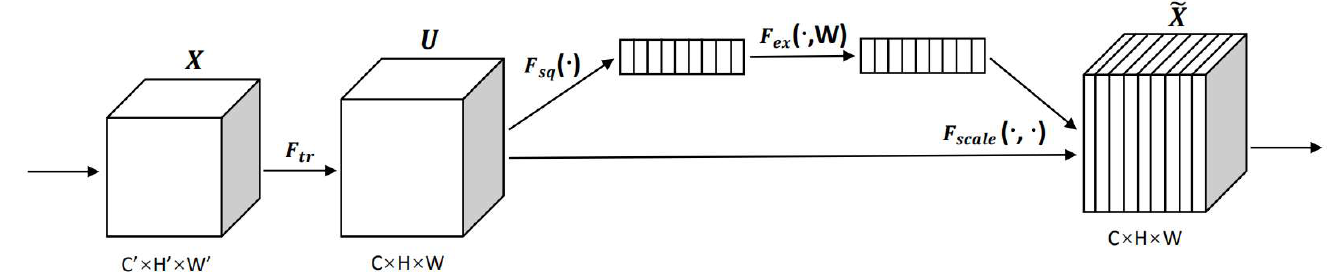
Figure 3. The network of SE.